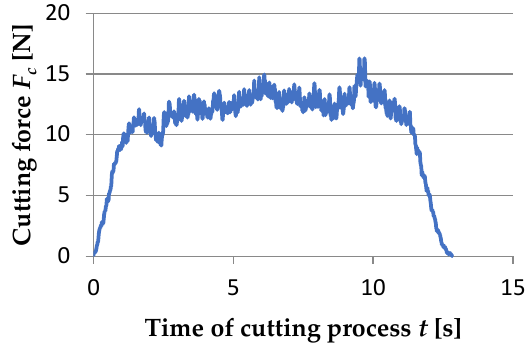
Figure 19. The graphs include exemplary results of forces in time of cutting process during turning of AlSi 11 /Al 2 O 3 with v c = 35 m/min, a p = 0.15 mm, f = 0.125 mm/rev.